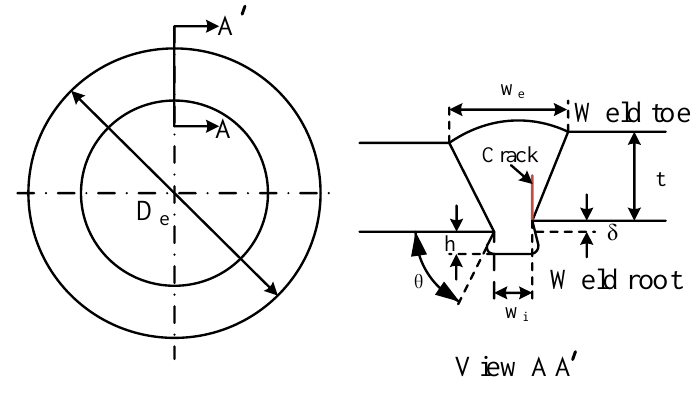
Figure 3. Weld root geometry.